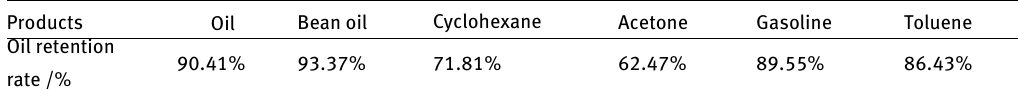
Table 4: The oil retention rate of HPRs for different oily substances